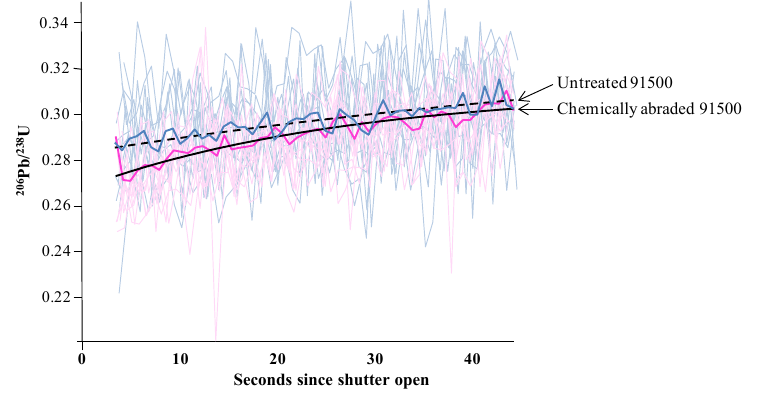
Figure 3. Comparison of time-resolved 206 Pb/ 238 U down-hole fractionation from static ablations (30 µm spot diameter) of untreated 91500 zircon (blue lines and dashed curve) and chemically abraded 91500 zircon (pink lines and solid curve) reference materials. Pale coloured lines indicate ratios from individual analyses, whereas heavy-coloured lines represent a time-resolved mean value calculated from all analyses. Black curves are calculated as a best-fit exponential spline through mean values. There is a ca . 3% difference between the two curves, taken as an average over the full duration of